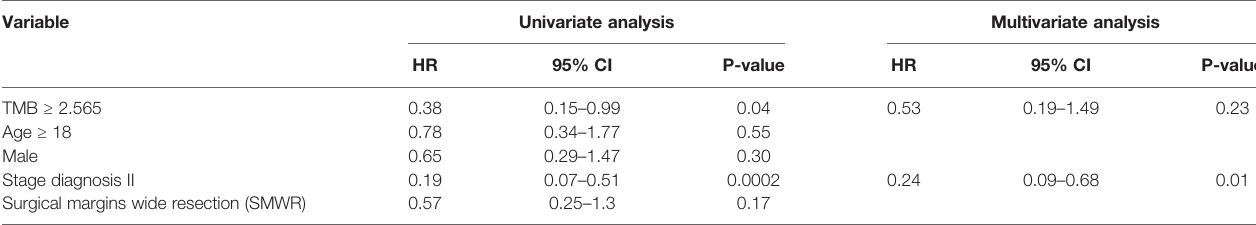
TABLE 3 | Analysis of factors associated with PFS.